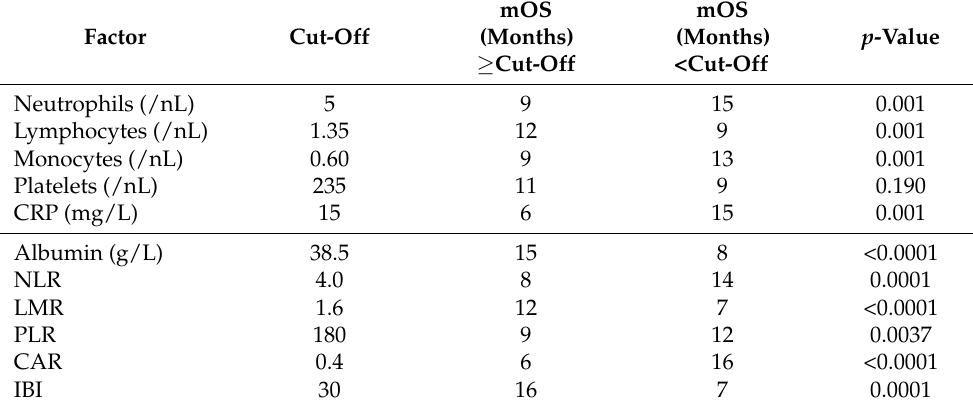
Table 2. Correlation of individual parameters with median overall